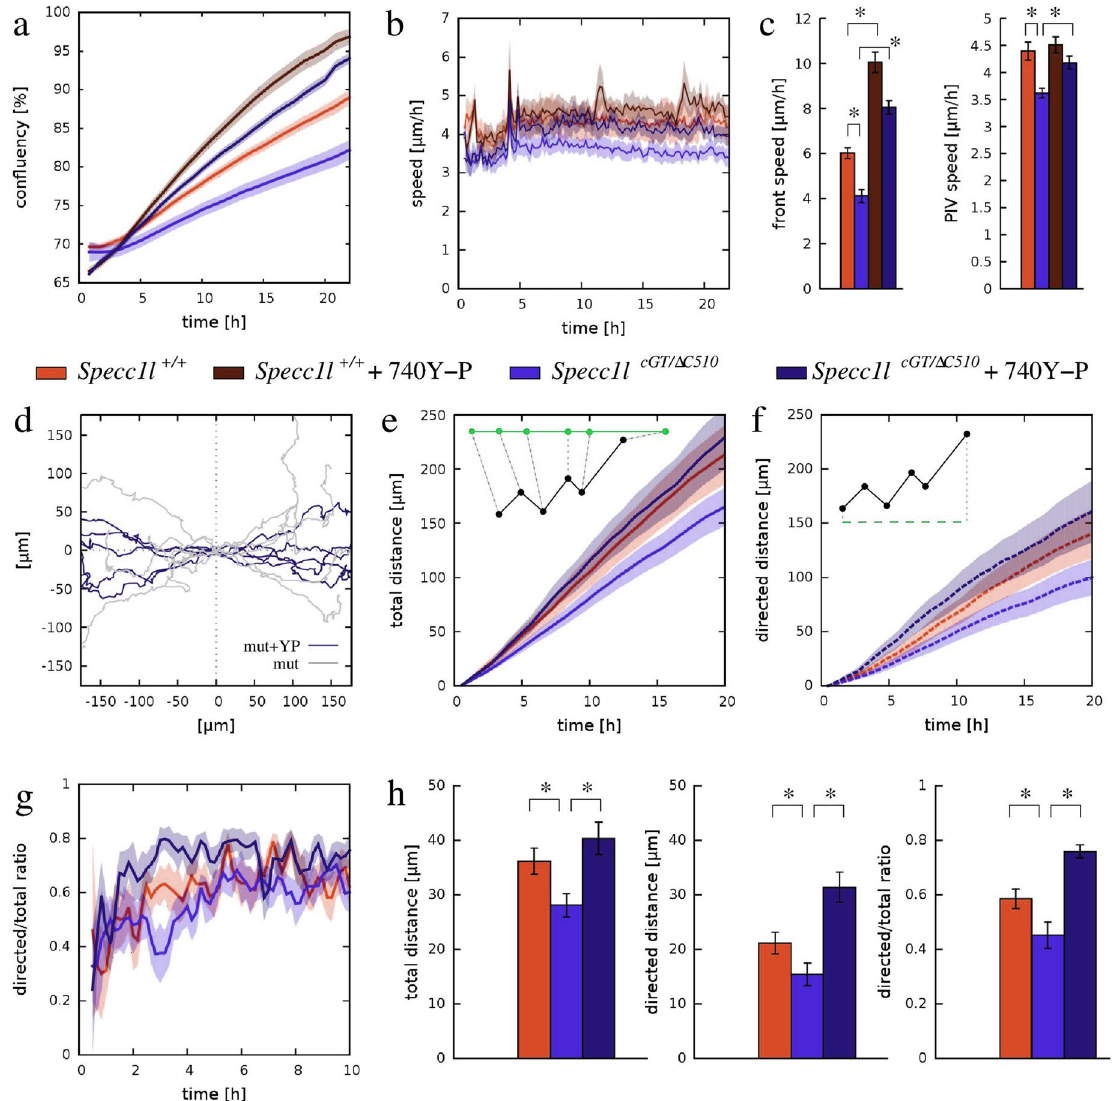
Figure 8. Upregulation of PI3K-AKT signaling rescues both speed and directionality of Specc1l cGT/ΔC510 mutant cells in wound-closure assays. ( a ) Confluency analysis of wound-closure recordings indicated a substantially increased speed of the process as a response of 100 µg/mL 740Y-P, a PI3K activator. Orange and blue colors indicate data obtained from wild-type (WT) and Specc1l- mutant cultures, while lighter and darker colors indicate vehicle-treated and 740Y-P treated cultures, respectively. Solid lines represent the average of 13 independent microscopic fields, recorded in 4 independent experiments. Shaded areas indicate SEM. ( b ) Average cell motility speed, calculated by PIV analysis of the wound-closure recordings analyzed in ( a ). The activator 740Y-P induced an increased motile activity, persistent for at least a day, in Specc1l -mutant cells. ( c ) Statistical analysis of data presented in ( a , b ) indicated that the motility defect of mutant MEPM cells was rescued by the PI3K-AKT activator 740Y-P. Left: average speed of front propagation, calculated within the 1–15 h time interval. The speed-up in wound-closure is significant (p < 5 × 10 −7 for WT and p < 3 × 10 −10 for mutant, Welch’s t-test). Right: average speed of cell movements within the entire recorded time period of 24 h. The increase of speed was significant in Specc1l -mutant cells (p < 4 × 10 −8 , Welch’s t-test). Error bars represent SEM. ( d ) Trajectories of individual, 740Y-P treated Specc1l -mutant MEPM cells (dark blue) was compared with that of untreated MEPM cells (gray). The PI3K-AKT activator enhanced the guidance of cell movements into the wound area. ( e – h ) Statistical analysis of individual cell trajectories. Total path length ( e ), net directed displacement into the wound ( f ) and their ratio ( g ) indicated a sustained improvement in the performance of Specc1l -mutant MEPM cells. ( h ) Bar charts indicating the cell trajectory measures evaluated at 10 h after the onset of migration. The significance of rescue was established by pairwise Welsh’s t-tests, yielding p-values of 2 × 10 −3 , 2 × 10 −5 , and 4 × 10 −7 for the total path length, net directed displacement and ratio data sets, respectively. The significance values for the WT-mutant comparison were reported in Fig.